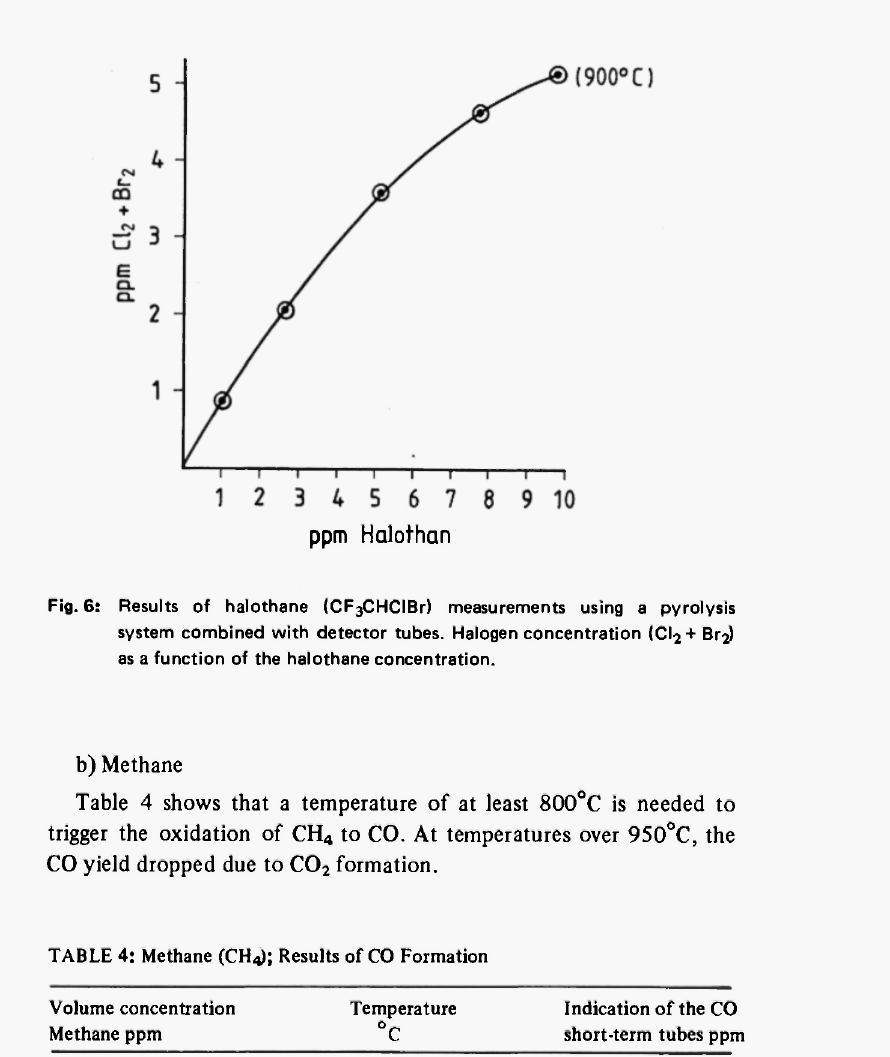
TABLE 4: Methane (CH4); Results of CO Formation Volume concentration Temperature Indication of the